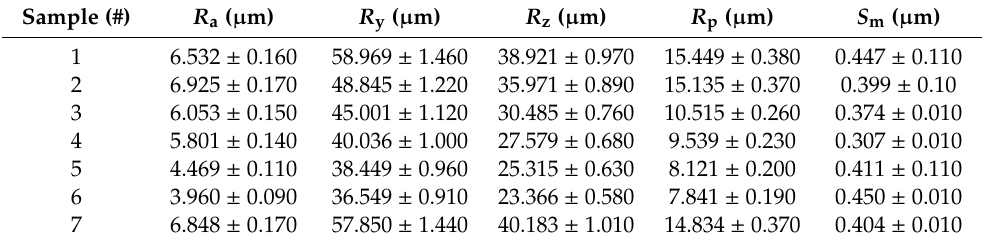
Table 2. Surface roughness